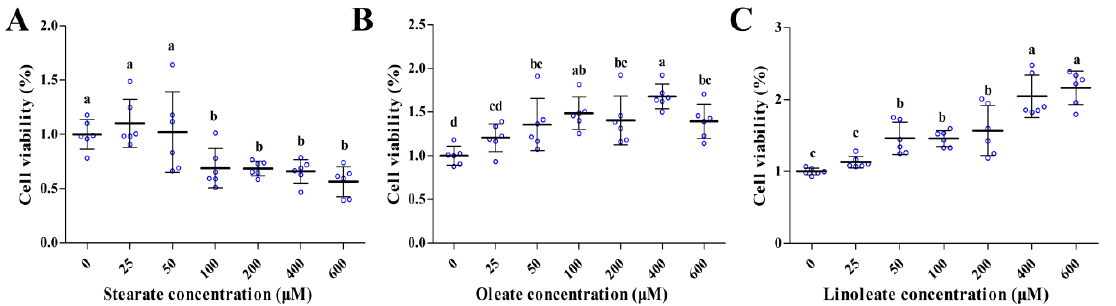
Figure 1. Effect of stearate, oleate and linoleate on cell viability in pMECs. pMEC cells were incubated with 0 (control), 25, 50, 100, 200, 400 and 600 µ M stearate ( A ), oleate ( B ) or linoleate ( C ), respectively, for 24 h. Cell viability was estimated by MTT test. Values, expressed as percentage of control, are presented as mean ± SD ( n = 6, blue dots display the number of measurements). Comparisons between groups were performed via ANOVA and Tukey’s range test for multiple comparisons. Different letters indicate statistical significance between different concentrations of stearate, oleate and linoleate treatment groups ( p < 0.05).